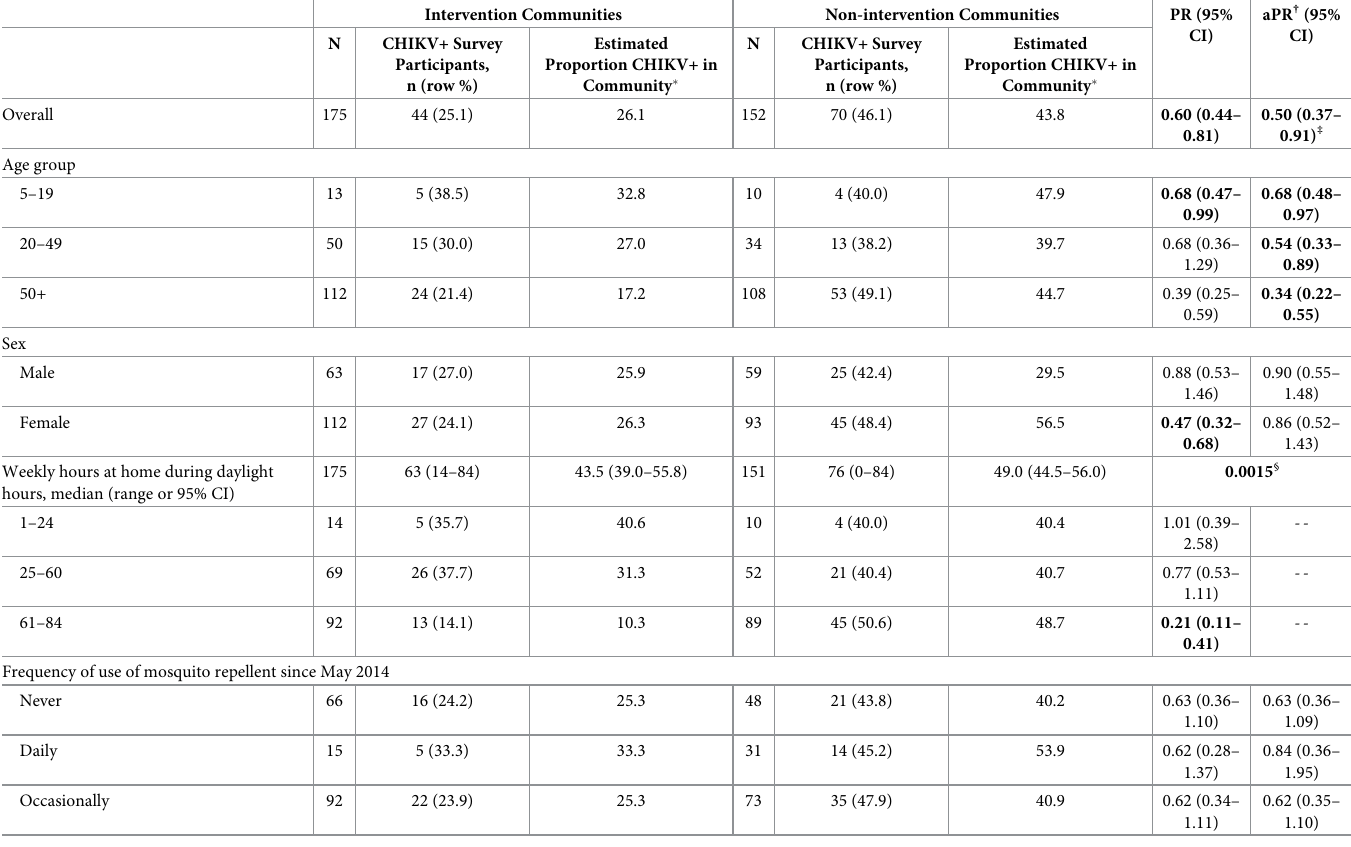
Table 2. Proportion of residents with serologic evidence of chikungunya virus infection from communities with (intervention) or without (non-intervention) auto- cidal gravid ovitraps (AGO traps) by demographic and behavioral characteristics, Puerto Rico, November 2015–February